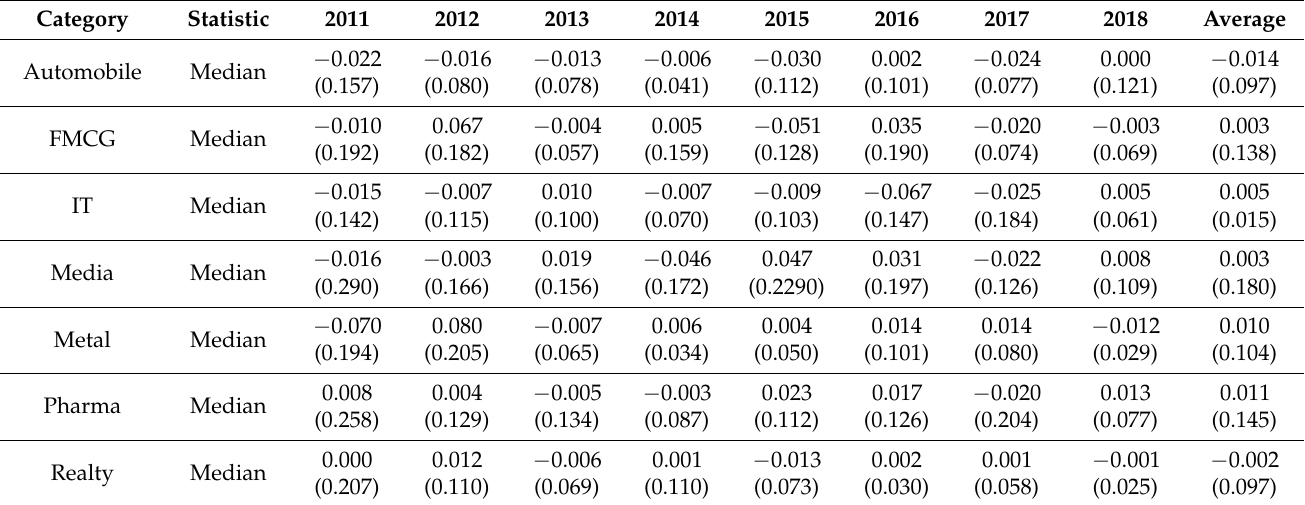
Table 5. Industry wise summary statistics (mean and standard deviation) of the discretionary accruals over the years. Category